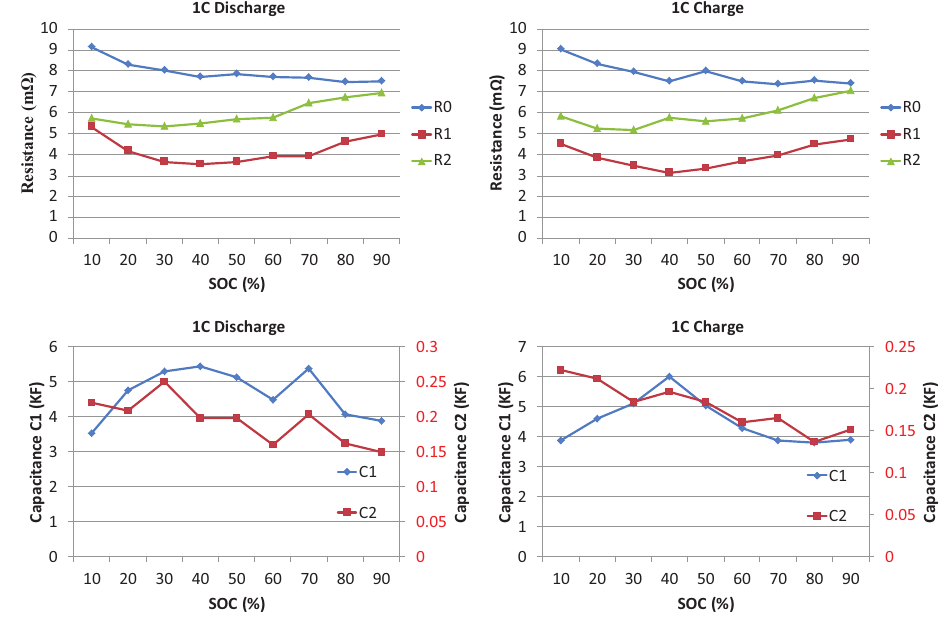
Figure 9. The internal resistance and polarization capacitance of